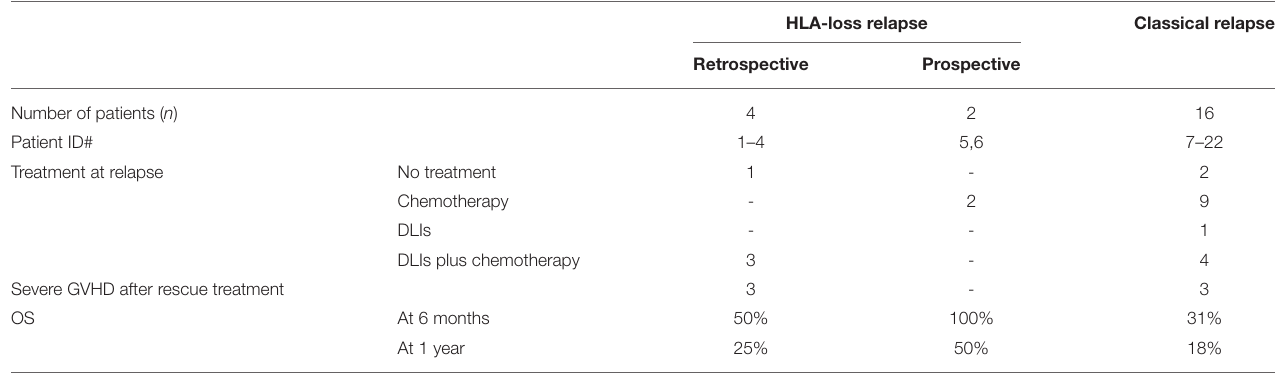
TABLE 3 | Rescue treatment and clinical outcome of patients with HLA-loss and classical relapses of